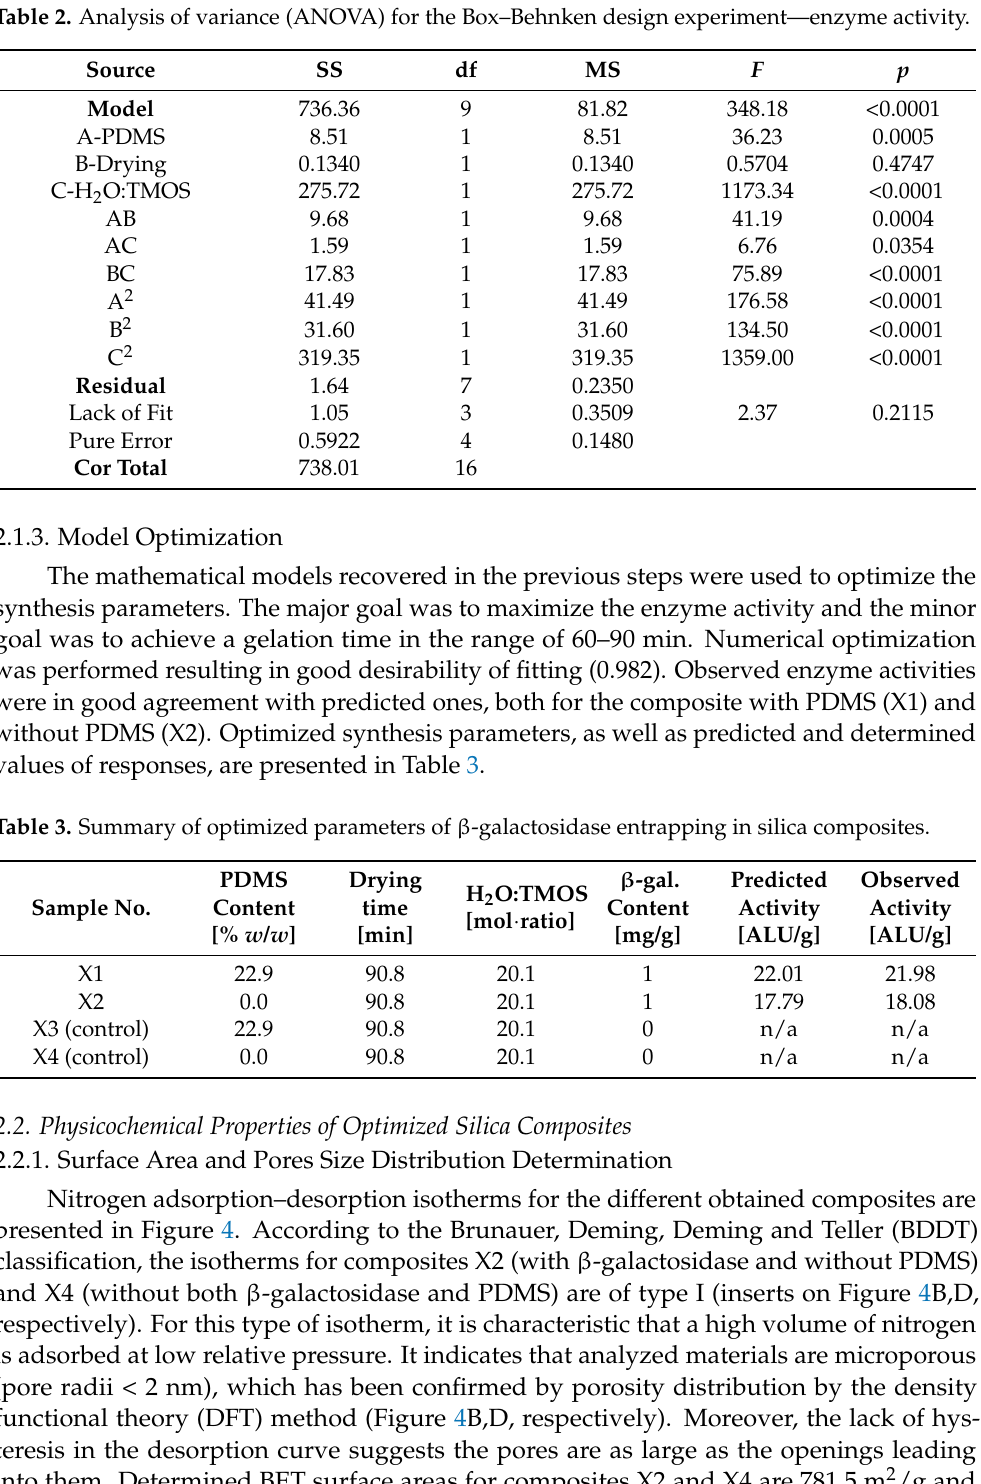
Table 2. Analysis of variance (ANOVA) for the Box–Behnken design experiment—enzyme activity.